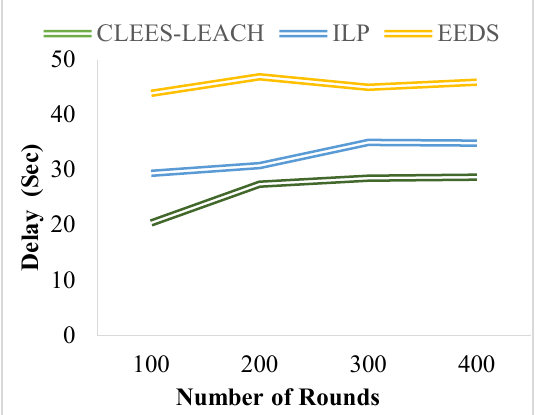
Figure 15. Latency Comparison Graph of CLEES-LEACH and Existing Protocols